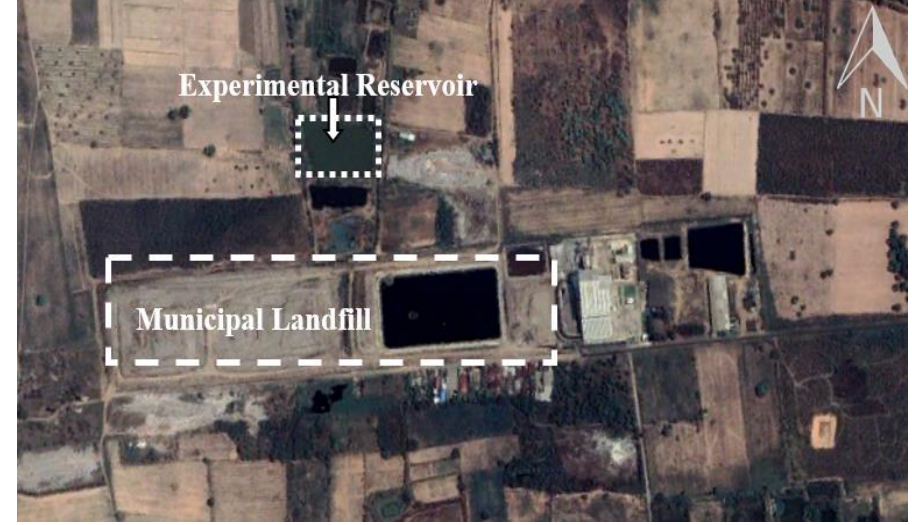
Figure 1. Location of the study site in a metal-contaminated reservoir near the Khon Kaen municipal landfill.